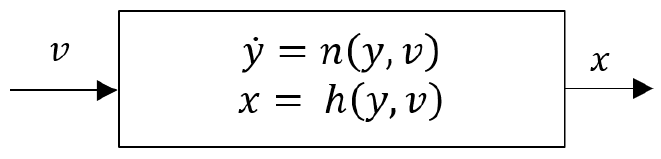
Figure 4. Continuous-Time model for platooning Figure 4 . Continuous-Time model for platooning vehicle.